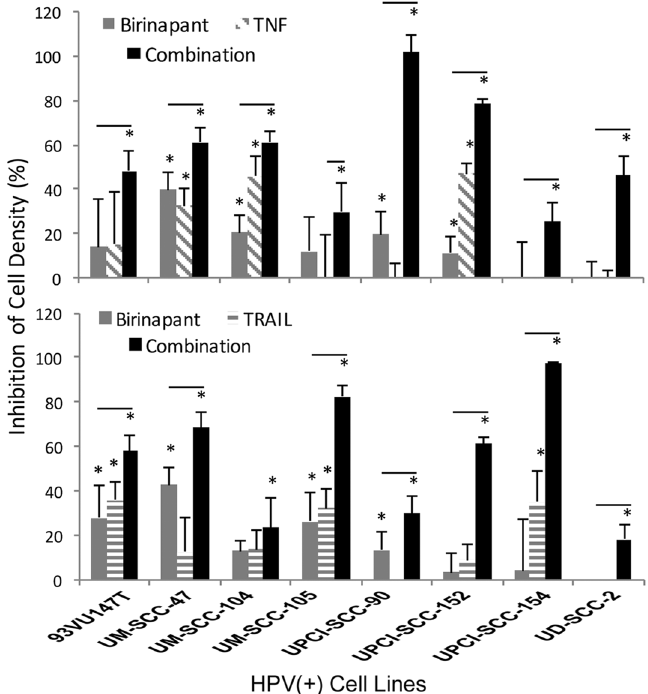
Figure 4. The anti-proliferative effects of birinapant, TNF, and TRAIL alone and in combination in HPV(+) cell lines. Effect of birinapant with and without death agonists TNFα or TRAIL were tested on 8 HPV(+) HNSCC cell lines. The top panel shows the percent inhibition assessed by XTT cell density assay on day 3 post treatment with 1 µM birinapant or 20 ng/mL TNFα alone or in combination. The bottom panel shows cell inhibition after treated with 1 µM birinapant or 50 ng/mL TRAIL alone or in combination. Independent experiments were performed to titrate the drug doses, the combination, and time points previously. Error bars, the standard deviation of 6 replicates are presented from a representative of independent experiments. Values were normalized to the untreated cells for the same experiment. Columns marked with * were statistically significantly different than the untreated control. Separately, a bar overlying the * indicates a statistically significant difference between combination treatment and the individual treatment(s) that the bar extends to. Student’s t test: *p <